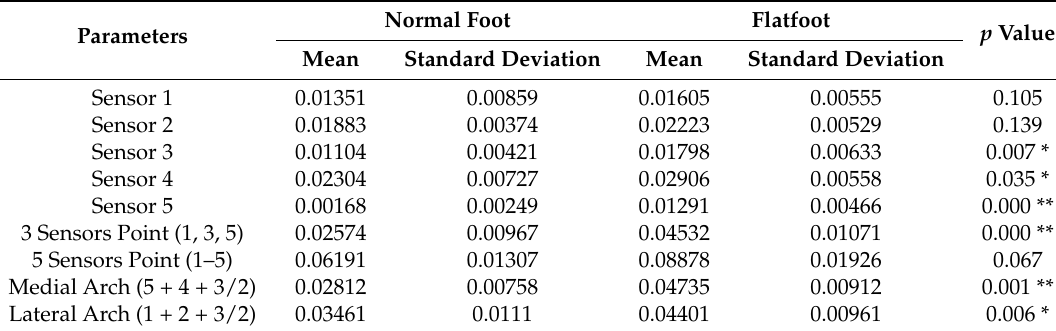
Table 5. Comparison of the normal and flatfoot pressure value in the dynamic